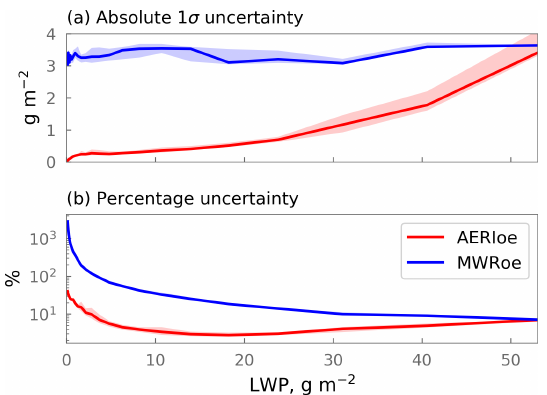
Figure 9. 1 σ uncertainty in the AERIoe (red) and MWRoe (blue) liquid water path (LWP) retrievals as a function of LWP. (a) Shows the absolute uncertainties, and (b) shows the percentage uncertain- ties. The solid line is the median of all retrievals and shading is the interquartile